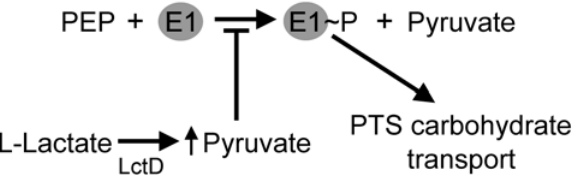
Figure 1. PTS substrate exclusion model. Lactate enters the cell through the lactate permease (LctP) and is converted to pyruvate by L- lactate dehydrogenase (LctD). Intracellular levels of pyruvate increase and prevent autophosphorylation of protein EI, thus inhibiting PTS- mediated carbohydrate transport. PEP is phosphoenolpyruvate.